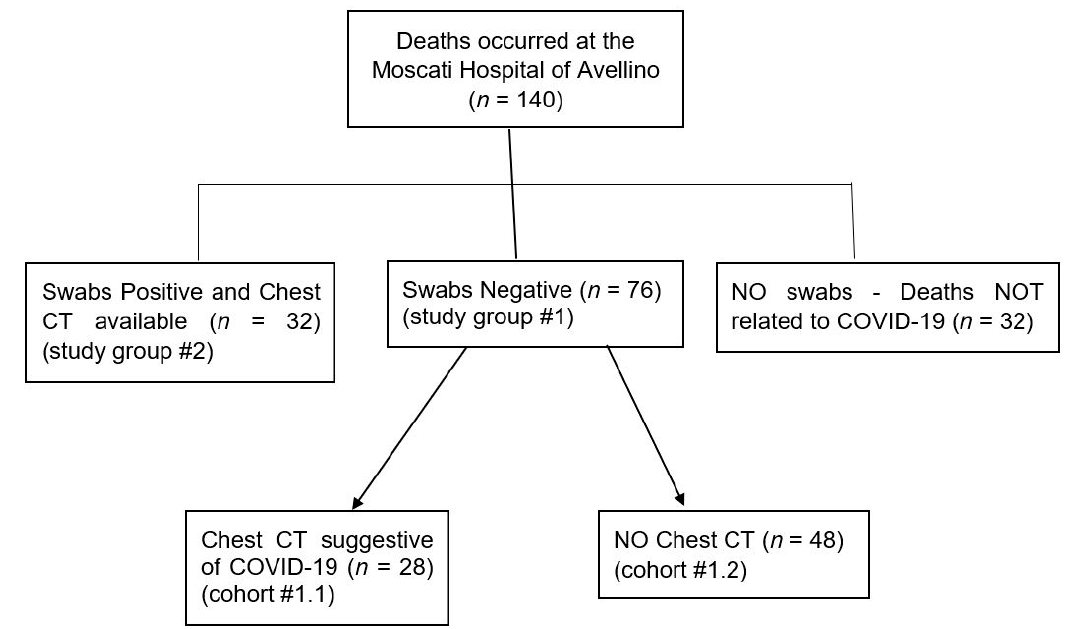
Figure 1. The flow diagram depicting the study groups.